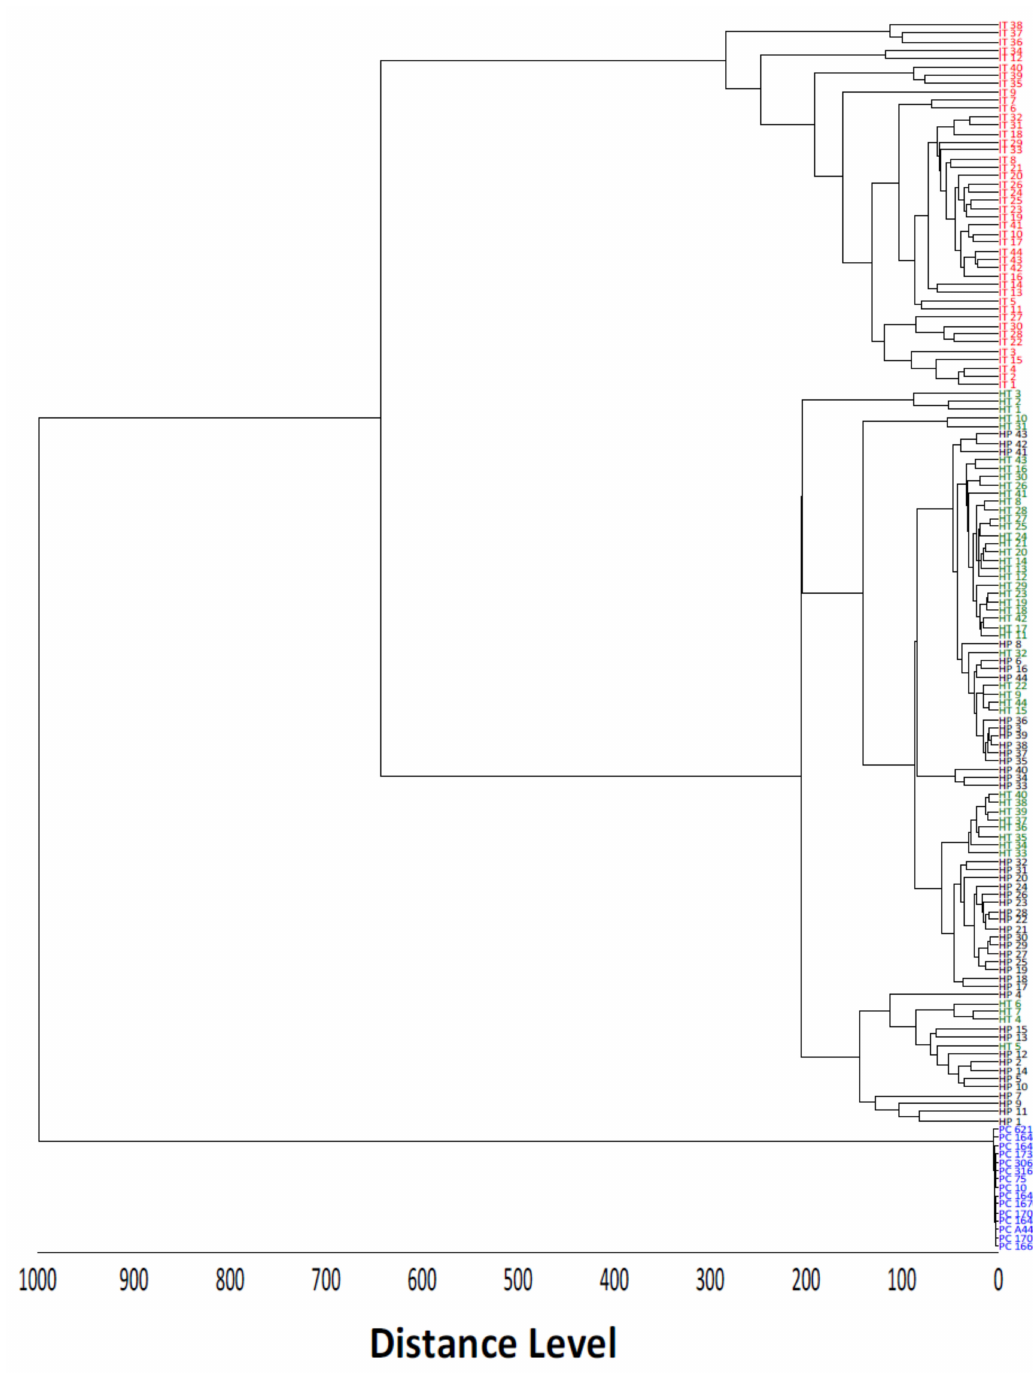
Figure 4. Maldi Biotyper MSP dendrogram of C. sinensis leaves samples from the field (IT, HT, and HP) and Xcc strains. IT: canker lesion, HT: healthy tissue, HP: herbicide phytotoxicity, PC: pure culture of Xcc